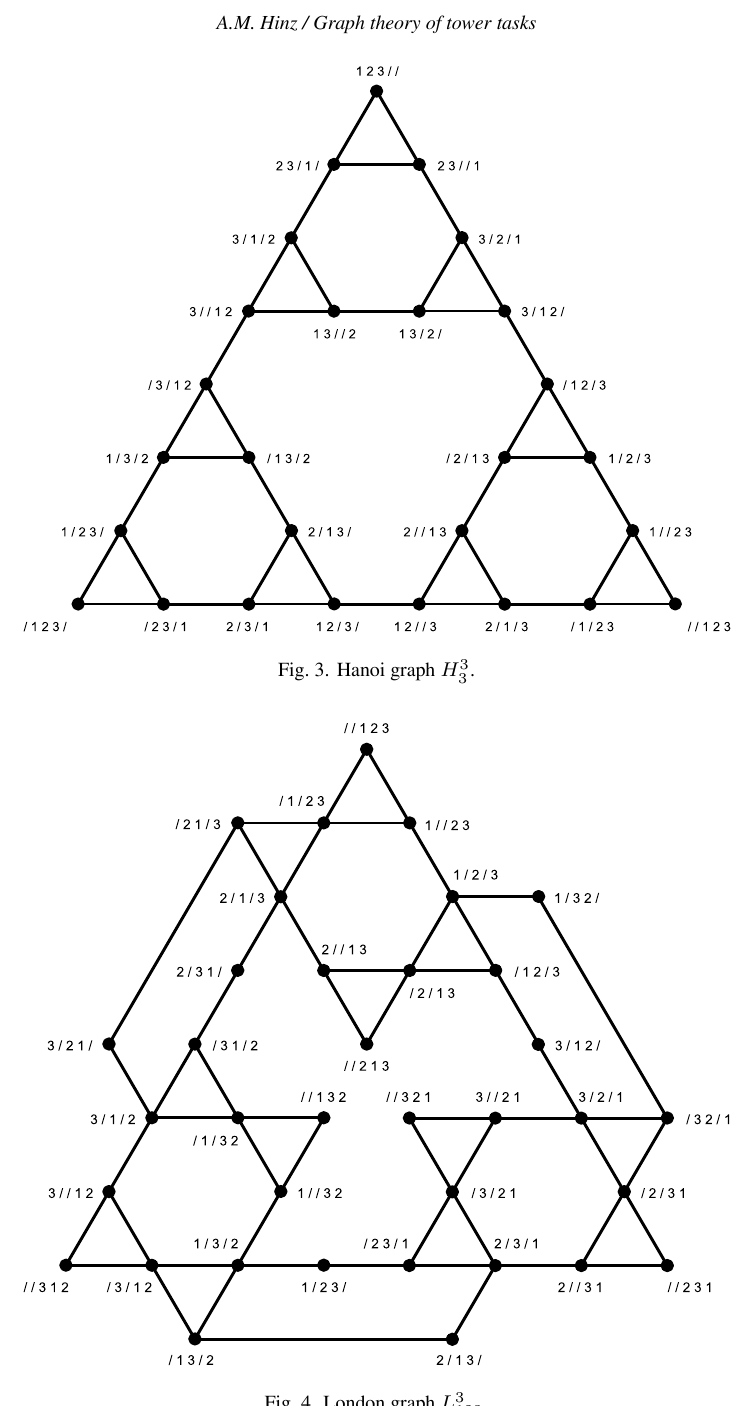
Fig. 4. London graph L 3 123